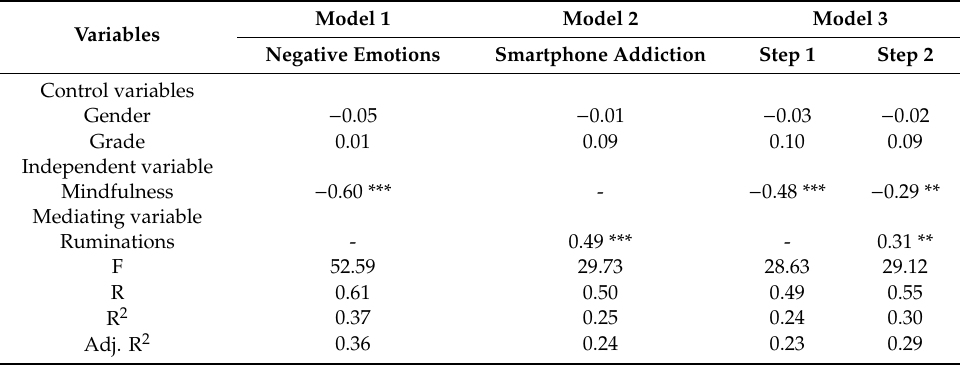
Table 3. The mediating e ff ect of rumination on the path from mindfulness to smartphone addiction before going to